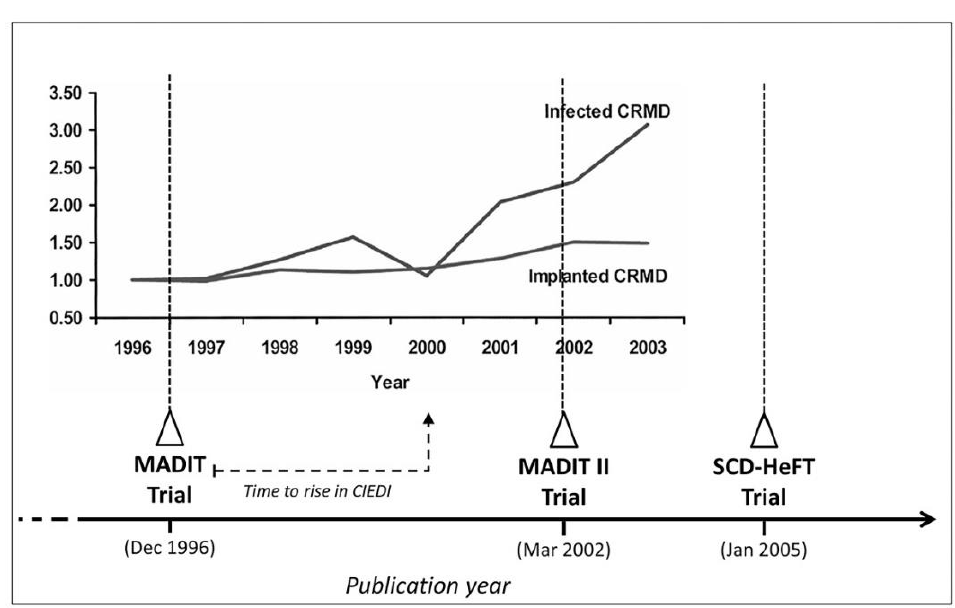
Figure 2. Relationship between the publication date of three leading randomized trials on implantable defibrillators for the primary prevention of sudden cardiac death and the disproportionate increase in the number of CIED infections with respect to implantation rate. Modified from “Infections of Cardiac Implantable Devices” by Diemberger, I.; Boriani, G., 2020, Infections of Cardiac Implantable Devices, VI, 229, Copyright [2020] by the Springer International Publishing. CMRD: cardiac rhythm management devices.